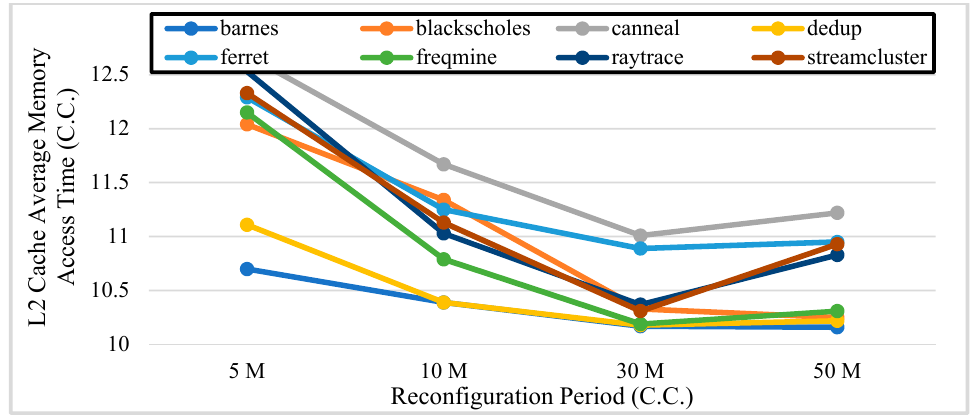
Figure 14. L2 cache AMAT of different reconfigurable periods.